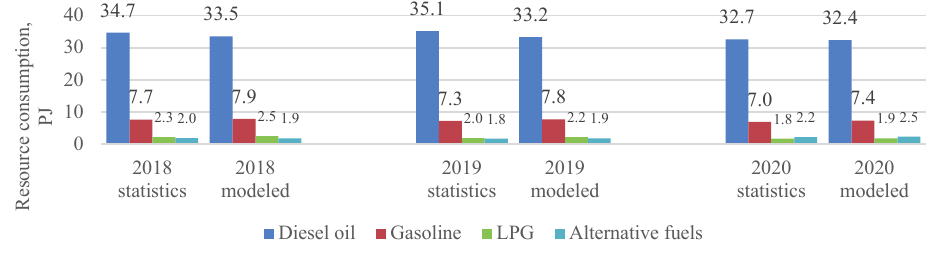
Fig. 7. Results of the BASE scenario and statistical data [25] of resource consumption in the transport sector for the years 2018, 2019 and